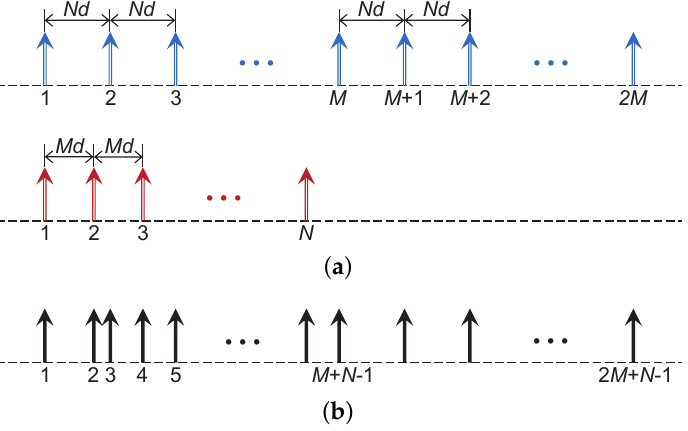
Figure 1. Illustration of the coprime array configuration. ( a ) the two uniform linear arrays for constructing the coprime array; ( b ) the non-uniform coprime